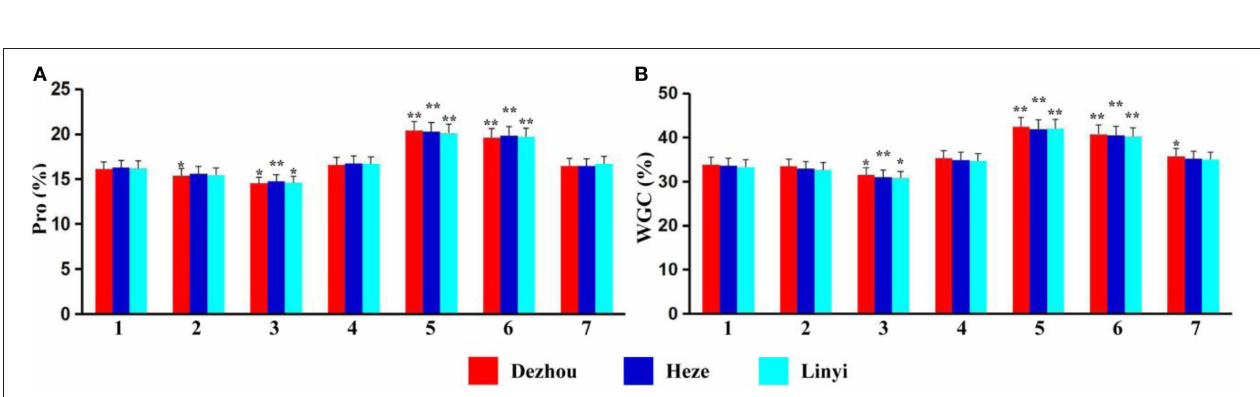
FIGURE 1 | Agronomical traits investigation result of the material tested. Spikelet number, grain number per 30 spikes and thousand-kernel weight data of Ji’nan are not obtained due to crop rotation.1–7 represent T. aestivum cv. Alcedo, Alcedo- Ae. caudata B to G addition lines. PH (A) , SL (B) , SNPS (C) , FLL (D) , FLW (E) , TNPP (F) , GNTS (G) , and TKW (H) are the abbreviations of Plant Height, Spike Length, Spikelet Number Per Spike, Flag Leaf Length, Flag Leaf Width, Tiller Number Per Plant, Grain Number of 30 Spikes and Thousand Kernel Weight, respectively. *significant at P < 0.05 by t -test as compared to relative data of ALCD; **significant at P < 0.01 by t -test as compared to relative data of ALCD. Bar represents standard deviation.